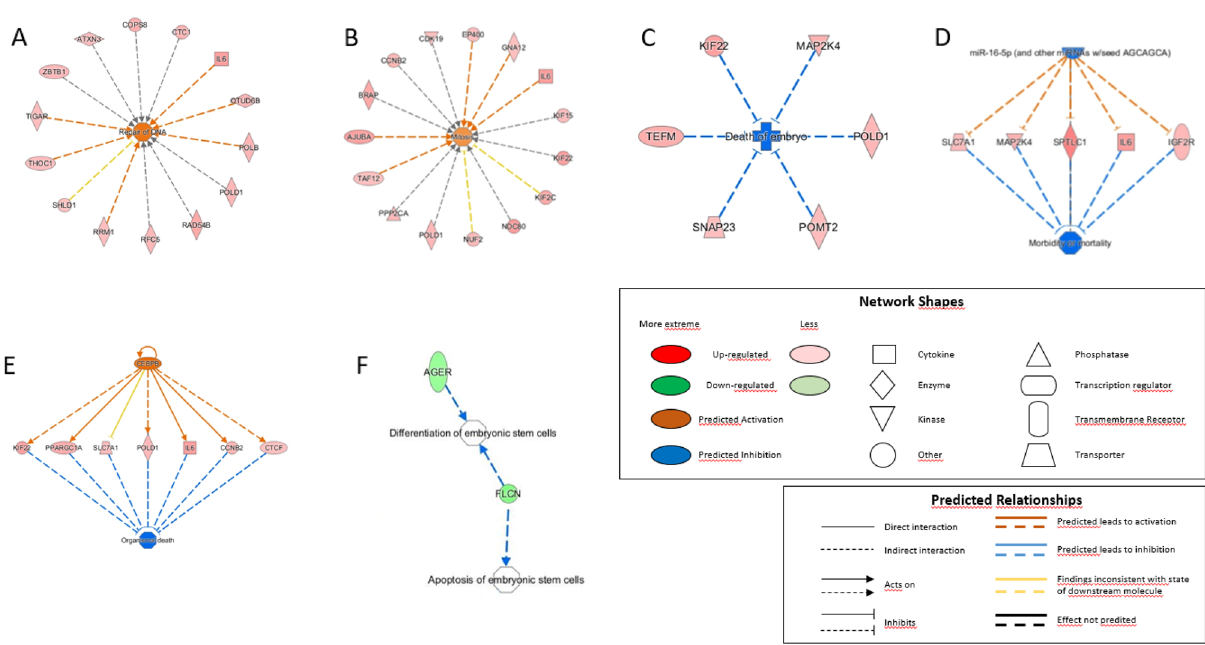
Figure 3. Functional annotation of the differentially expressed genes using the Ingenuity Pathway